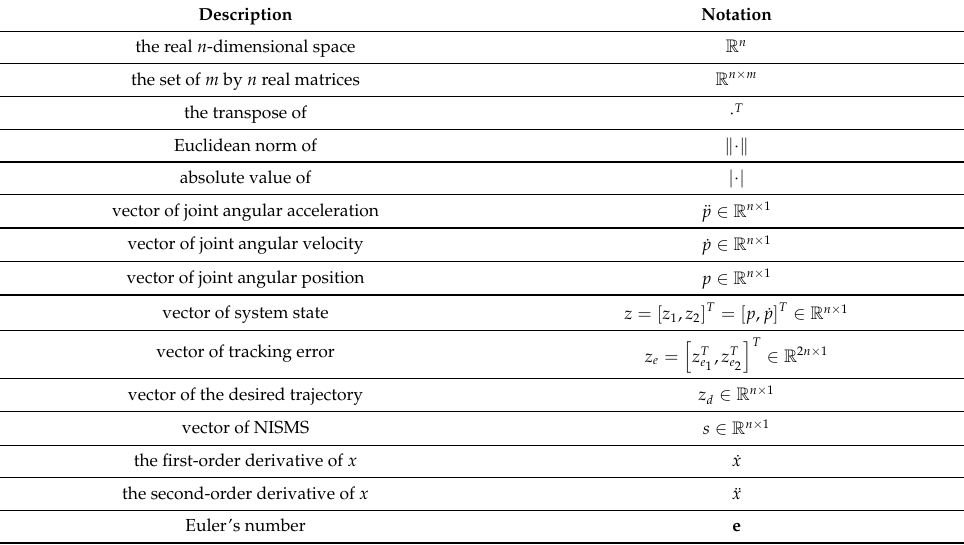
Table 1. List of